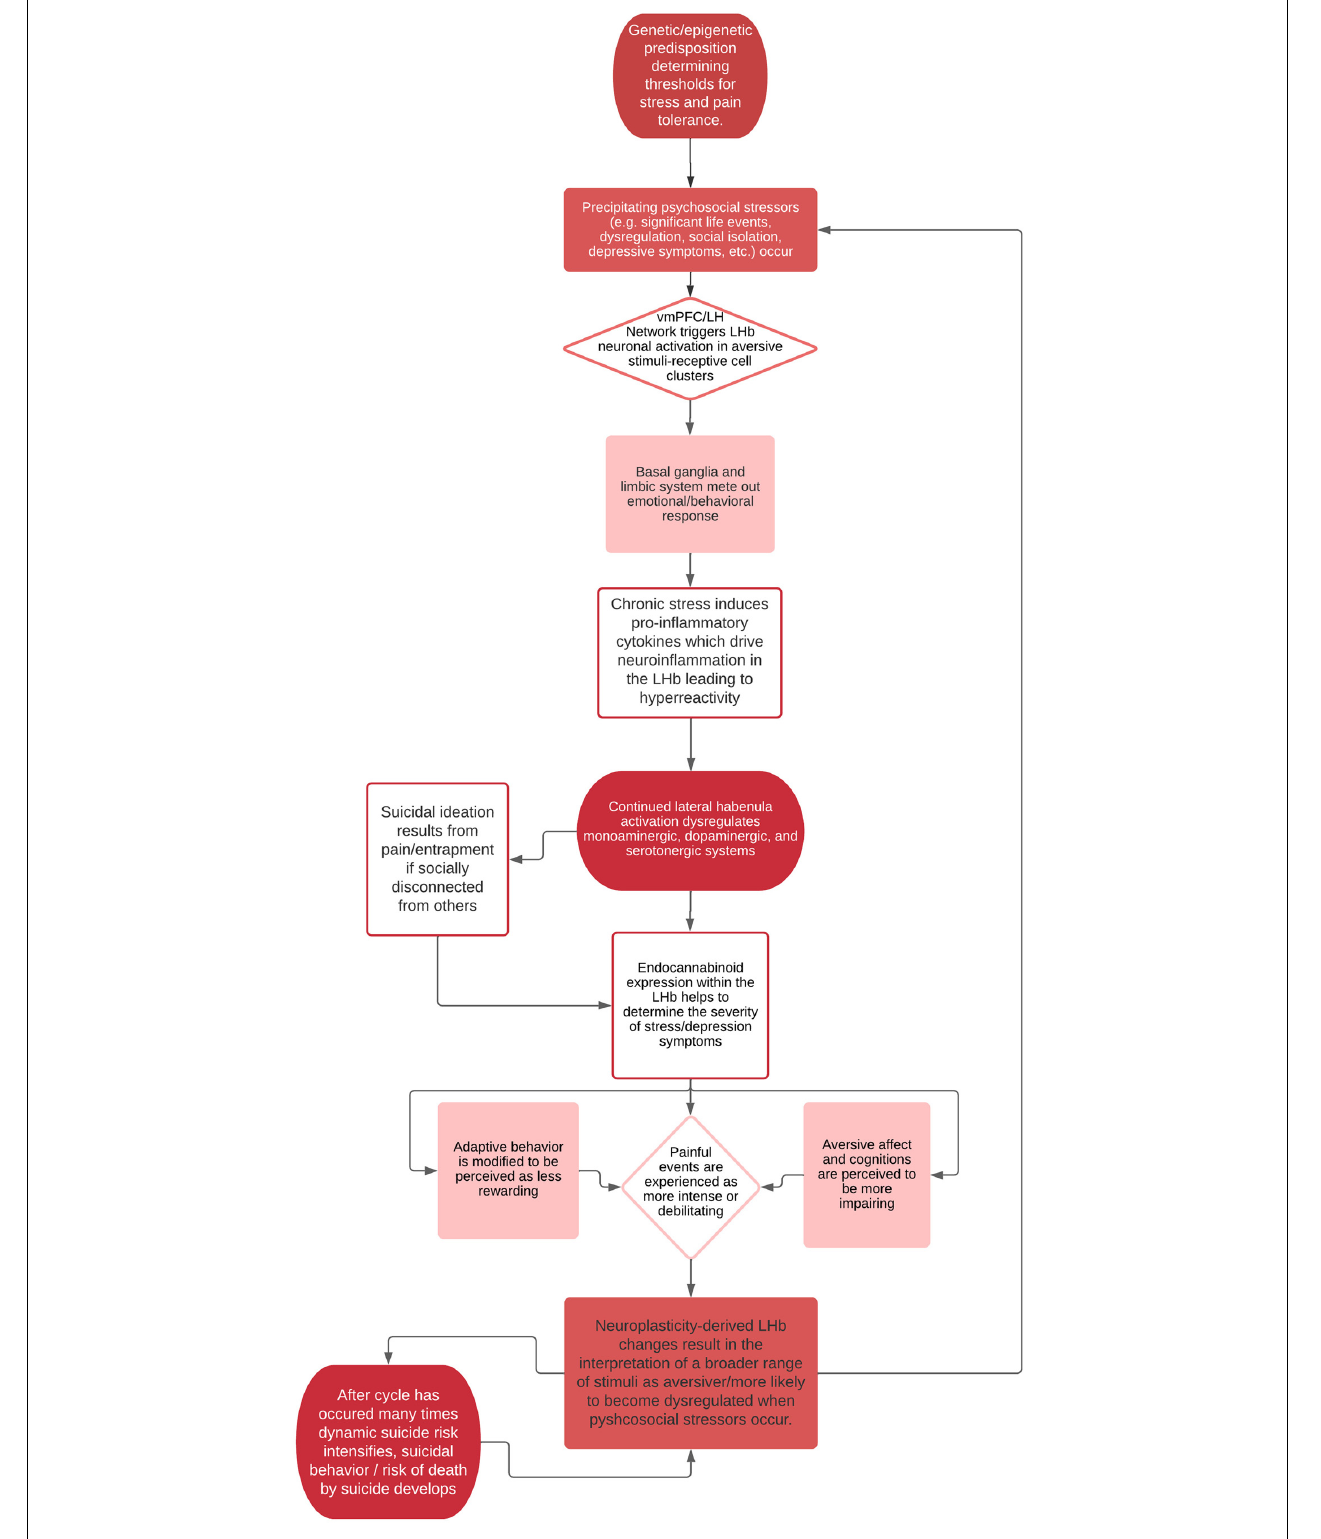
FIGURE 1 | Theoretical process of habenular “suicide